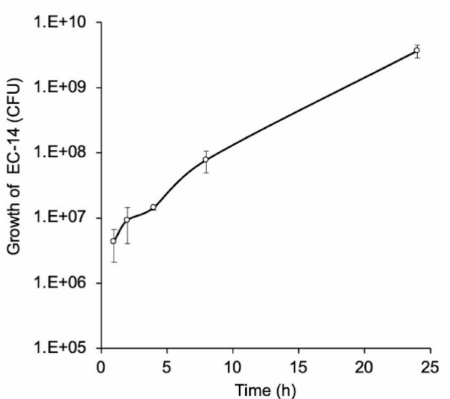
Figure 5. Growth curve of E. coli EC-14 in lung-infection-model mice. EC-14 at 3–7 × 10 7 CFU/80 µ L was infected to the lung of mice. At 1, 2, 4, 8, and 24 h after infection, the mean CFU of EC-14 was approximately 4.3 × 10 6 , 9.2 × 10 6 , 1.4 × 10 7 , 7.8 × 10 7 , and 3.7 × 10 9 ,